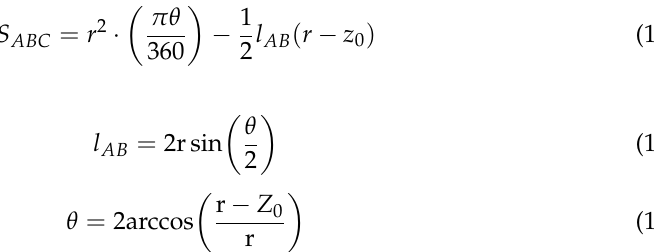
Figure 6. Schematic diagram of the effective area of the disc grounding.